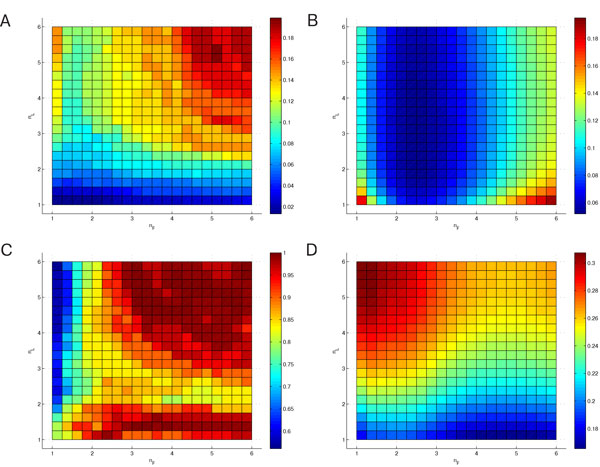
Significance of FuzzyMEn for different choices of nL and nF. Significance of FuzzyMEn for different choices of nL and nF for rL = rF = rChon (A, C) and rL = rF = 0.2 σ (B, D); parameters: m = 2, N = 1000, databases: chf2 vs. np (A, B) and mit vs. np (C, D)